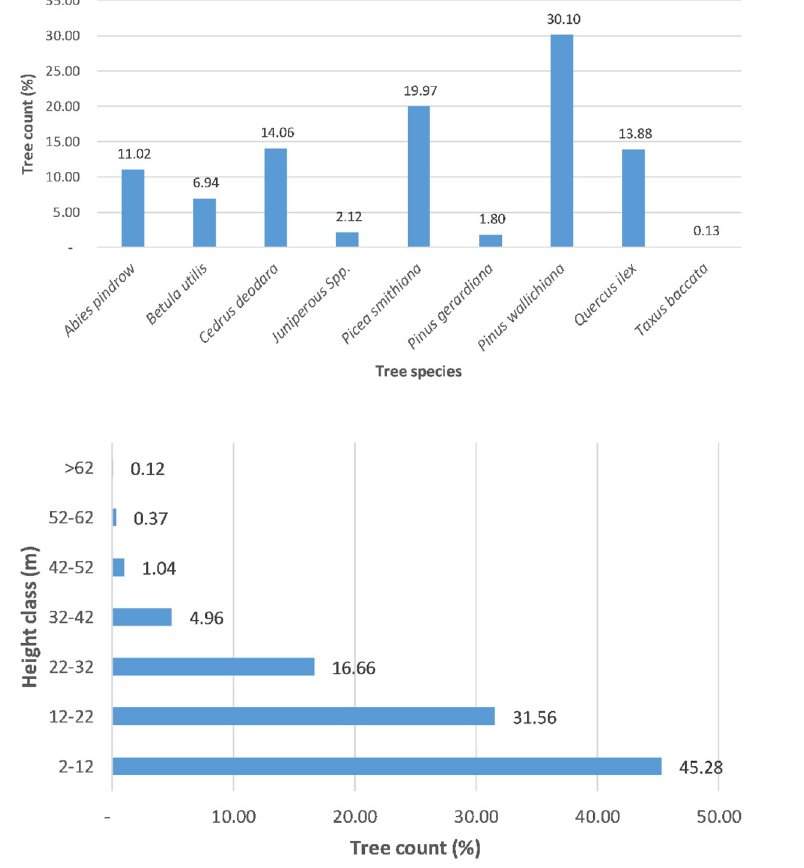
Figure 3. Tree height-wise